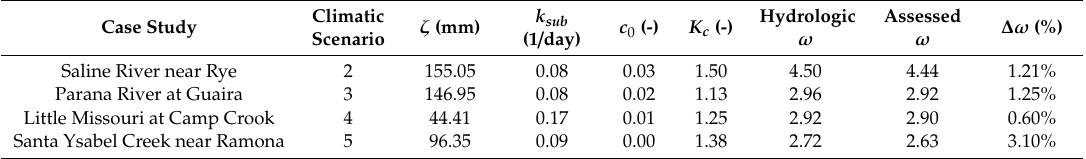
Table 4. Case study basins, their associated climatic scenario, and morphological and vegetation parameters, evaluated by a “general database”, composed by the MOPEX database [35], Padr ó n, et al. [48], Melo, Scanlon, Zhang, Wendland and Yin [45], and other mixed information. The last three columns point out the results of comparison between “hydrological ω ” (obtained by the Fu’s expression) and “assessed ω ” (obtained by the proposed regression